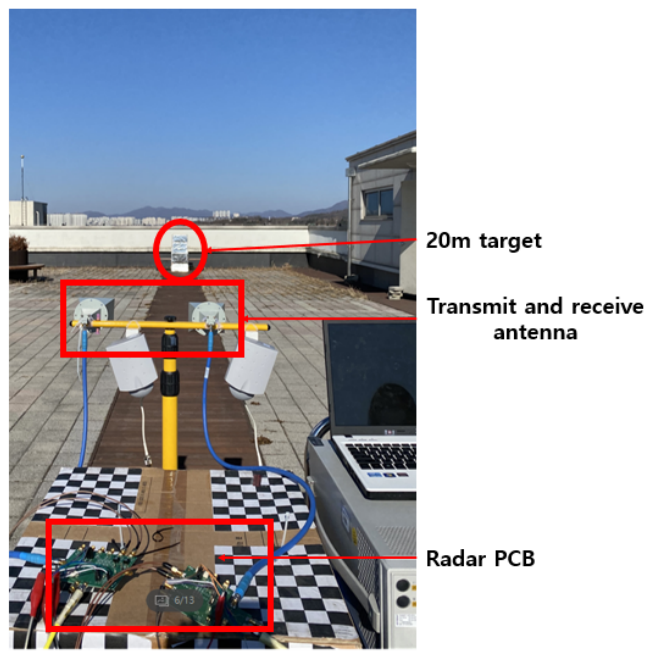
Figure 46. FMCW mode radar test